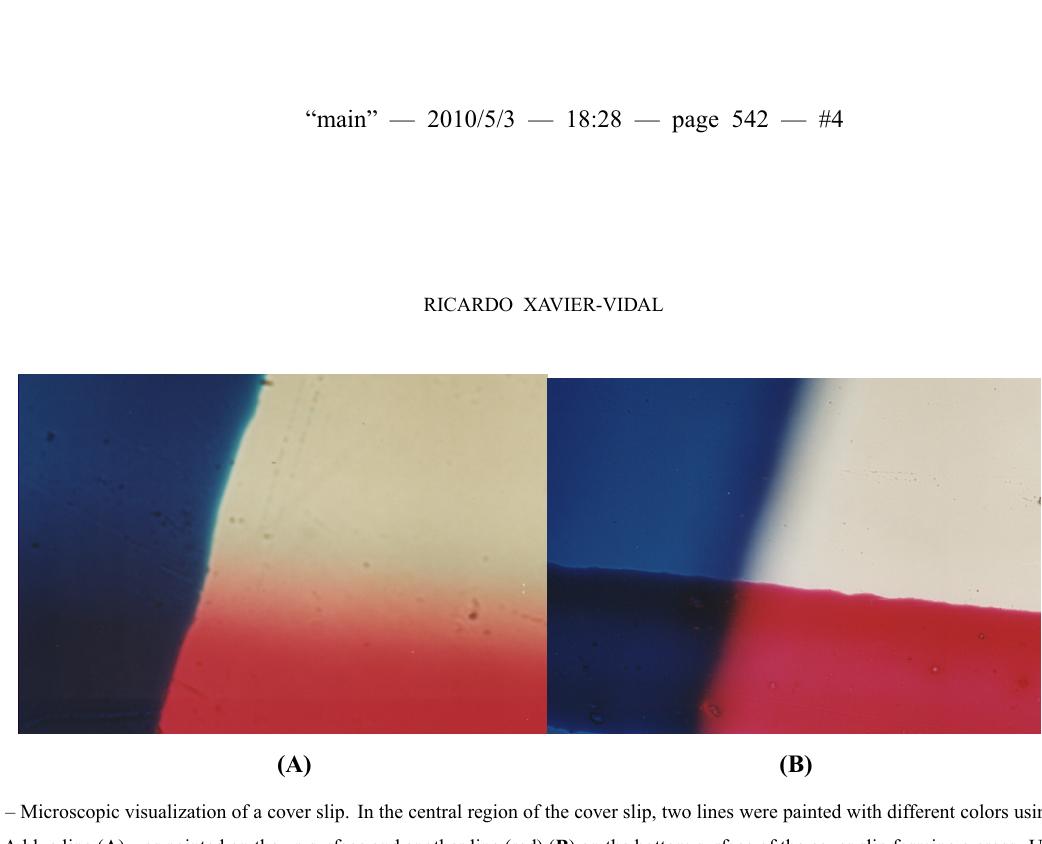
Fig. 2 – Microscopic visualization of a cover slip. In the central region of the cover slip, two lines were painted with different colors using a pen glass. A blue line ( A ) was painted on the up surface and another line (red) ( B ) on the bottom surface of the cover slip forming a cross. Using the “manual digimatic outside micrometer scale” (Mitutoyo, Japan), we found the thickness of 0.160 mm (160 μ m), from the superior surface of the superior line (blue) painted on the cover slip to the inferior surface of the cover slip (without painting the red line). The inferior surface of the cover slip was not painted (red line) in this procedure because, in the following procedure, we also used the superior surface of this inferior line painted on the bottom of the cover slip (tight to the glass) in order to calibrate the Z-axis. After this, it was necessary to check out the fine focuses scale of the microscope, the Z-axis distance from the superior surface of the superior line painted on the cover slip to the superior surface (tight to the glass) of the inferior line painted on the bottom surface of the cover slip as said before. In our microscope, we found this distance equal to 51 micrometers (Fig. 2). The scale of the fine focuses in our microscope was 50 micrometers (which means a rout of 360 degrees in fine focuses).